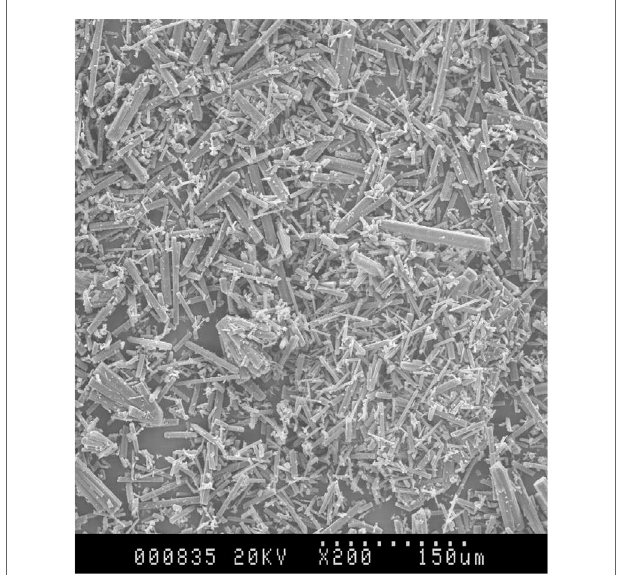
FigUre 2 | Typical low magnification seM photo of nesquehonite, MgcO 3 ⋅ 3h 2 O (synthesis conditions: 25°c, 4 h, 0.1 mol of Mgcl 2 and na 2 cO 3 , total volume 1.1 l) .